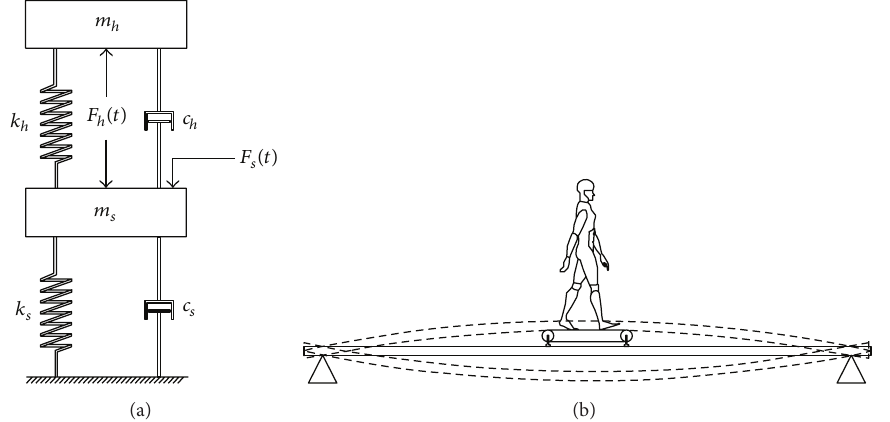
Figure 5: (a) The mathematical 2-DOF model of human-structure system and (b) the conceptual representation of a stationary human walking on the structure.